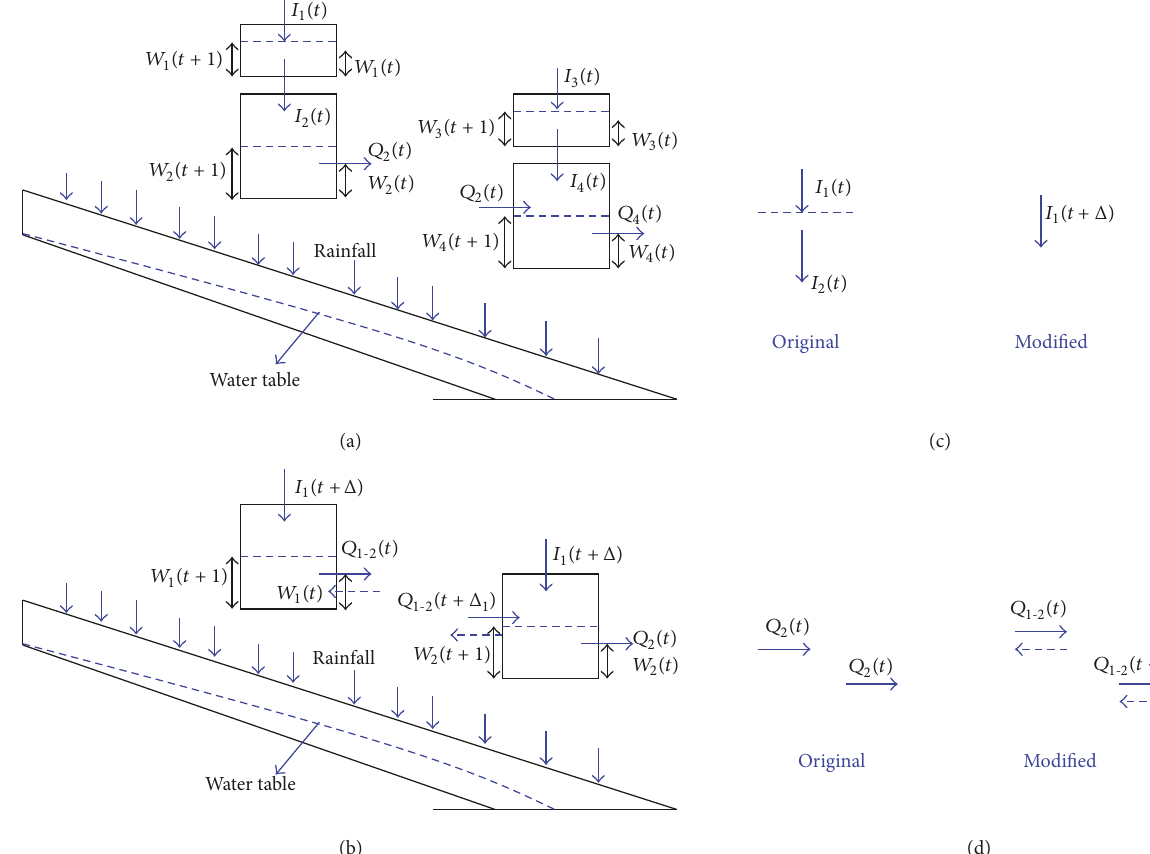
Figure 2: Comparison of original and modified multistorage tank models: (a) original multistorage tank model; (b) modified multistorage tank model; (c) optimizing the infiltration time lag; (d) optimizing the lateral water flow time